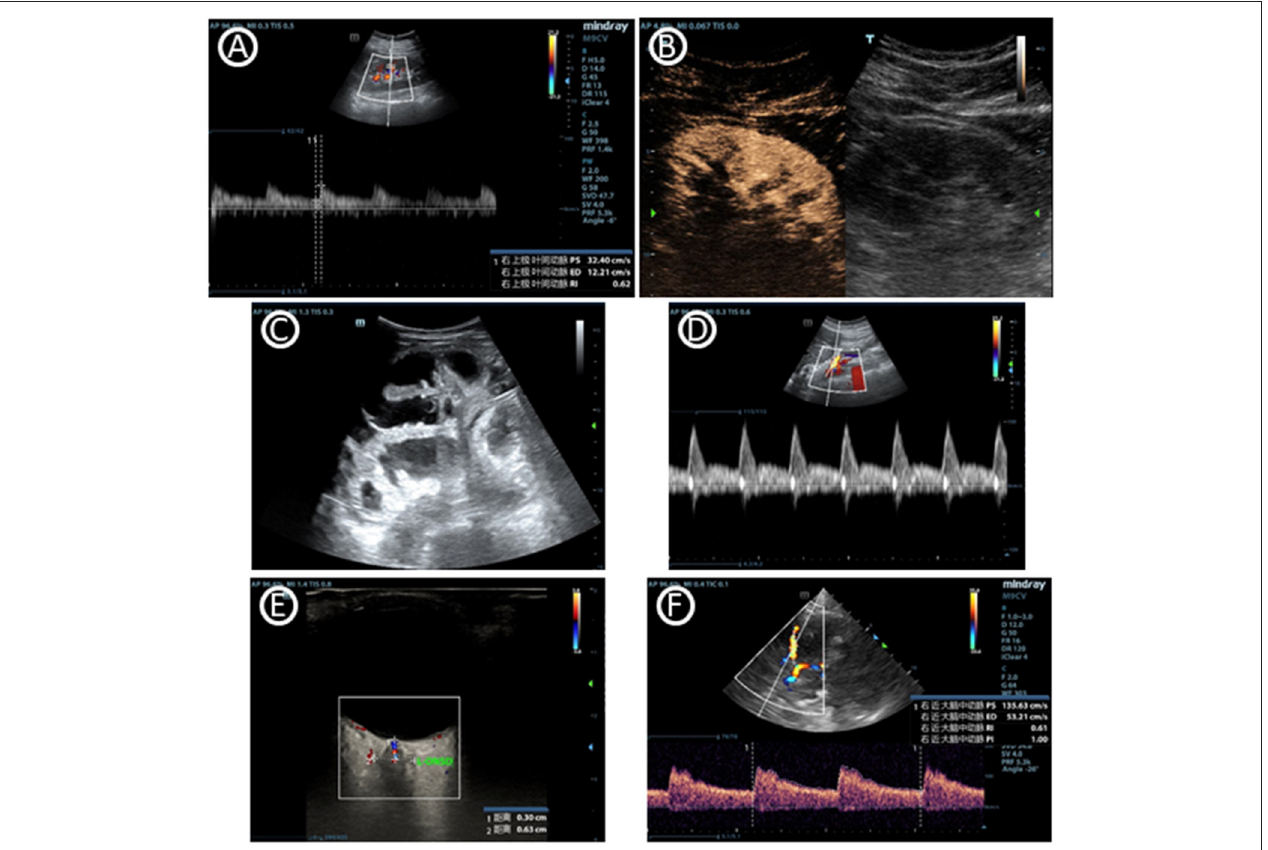
FIGURE 3 | Images of multiorgan ultrasound. (A) Normal doppler tracing of the interlobar vessels in renal ultrasound. The renal resistive index can be measured using the maximal and the minimal arterial velocity during the cardiac cycle. (B) Renal contrast-enhanced ultrasonography. (C) Dilated fluid-filled bowel loops that indicates small bowel obstruction. (D) Blood flow curve of superior mesenteric vein. (E) Optic nerve sheath diameter, which can help to predict intracranial pressure. (F) Cerebral blood flow velocity of middle cerebral artery accessed by transcranial doppler